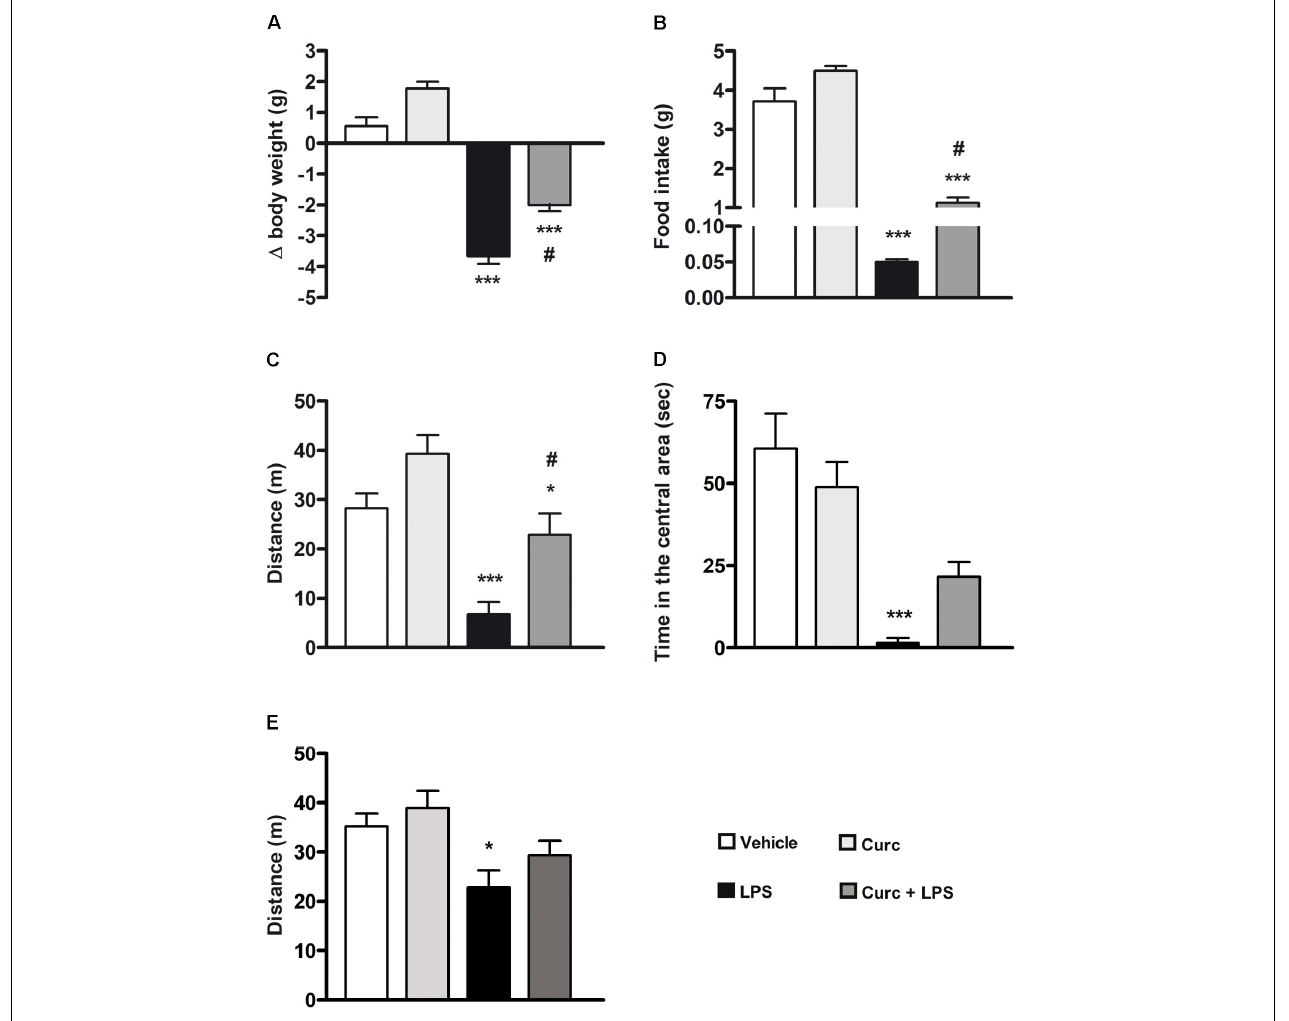
FIGURE 4 | Curcumin attenuates the acute symptoms of sickness behavior caused by peripheral LPS administration. Mice treated for 2 consecutive days with curcumin (curc; 50 mg/kg) received a single i.p. injection of LPS (5 mg/kg). (A) Twenty-four hours following LPS or saline injection, body weight was measured as described in Section “Materials and Methods.” Data are means ± SEM ( n = at least 7 mice/group). Data were analyzed by one-way ANOVA [ F ( 3 , 28 ) = 97.03, p < 0.0001] followed by Bonferroni’s multiple comparison test. ∗∗∗ p < 0.001 vs. control group; # p < 0.05 vs. LPS-stimulated group. (B) Twenty-four hours following LPS or saline injection, the amount of food intake was measured as described in Section “Materials and Methods.” Data are means ± SEM ( n = 7 mice/group). Data were analyzed by one-way ANOVA [ F ( 3 , 24 ) = 136.30, p < 0.0001] followed by Bonferroni’s multiple comparison test. ∗∗∗ p < 0.001 vs. control group; # p < 0.05 vs. LPS-stimulated group. (C) Twenty-four hours following LPS or saline injection, total distance traveled was measured as described in Section “Materials and Methods.” Data are means ± SEM ( n = at least 7 mice/group). Data were analyzed by one-way ANOVA [ F ( 3 , 34 ) = 10.98, p < 0.0001] followed by Bonferroni’s multiple comparison test. ∗ p < 0.05 and ∗∗∗ p < 0.001 vs. control group; # p < 0.05 vs. LPS-stimulated group. (D) Twenty-four hours following LPS or saline injection, amount of time spent in the central area of the open field arena was measured as described in Section “Materials and Methods.” Data are means ± SEM ( n = 7 mice/group). Data were analyzed by one-way ANOVA [ F ( 3 , 24 ) = 24.58, p < 0.0001] followed by Bonferroni’s multiple comparison test. ∗∗∗ p < 0.001 vs. control group. (E) Seven days after LPS treatment, total distance traveled was also measured. Data are means ± SEM ( n = at least 7 mice/group). Data were analyzed by one-way ANOVA [ F ( 4 , 43 ) = 4.33, p = 0.0094] followed by Bonferroni’s multiple comparison test. ∗ p < 0.05 vs. control